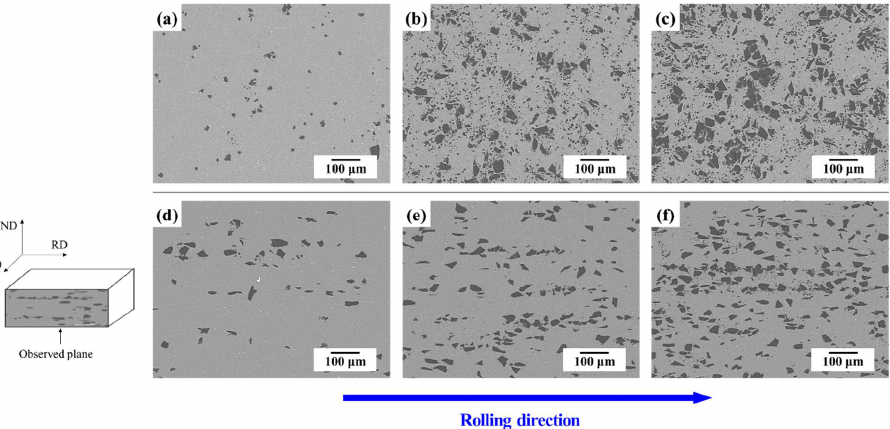
Figure 1. Scanning electron microscope images of stir-cast B 4 C/Al6061 composites with ( a ) 5 vol.%, ( b ) 10 vol.%, and ( c ) 20 vol.% B 4 C, and hot-rolled B 4 C/Al6061 composites with ( d ) 5 vol.%, ( e ) 10 vol.%, and ( f ) 20 vol.% B 4 C. Figure 2 shows 3D images of 5 and 20 vol.% B 4 C/Al6061 composites analyzed by a 3D X-ray tomography microscope. Like the 2D SEM image, it can be seen that three-di- mensionally arranged B 4 C particles are observed in the stir-cast B 4 C/Al6061 composites